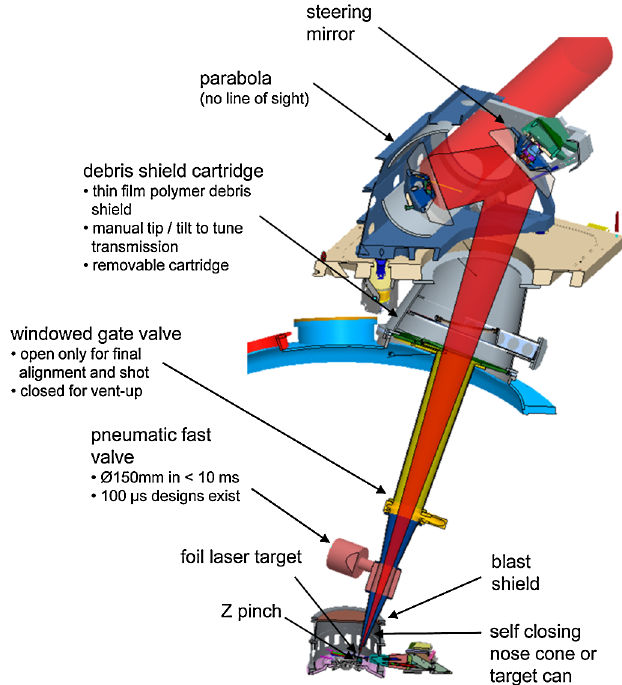
FIG. 2. (Color) Schematic of the FOA on top of the Z machine.